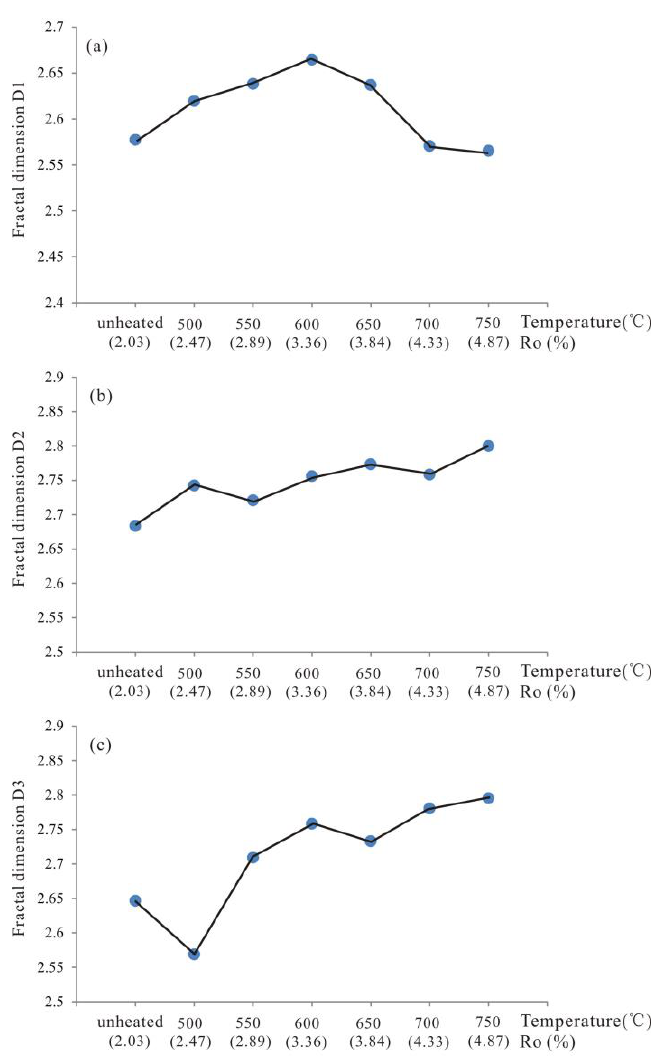
Figure 13. ( a ) Relationships between fractal dimension D1 and temperature (%Ro), ( b ) relationships between fractal dimension D2 and temperature (%Ro), and ( c ) relationships between fractal dimension D3 and temperature (%Ro). Table 4. Fractal dimensions obtained from N 2 physisorption and mercury intrusion of the shale samples with different temperatures.